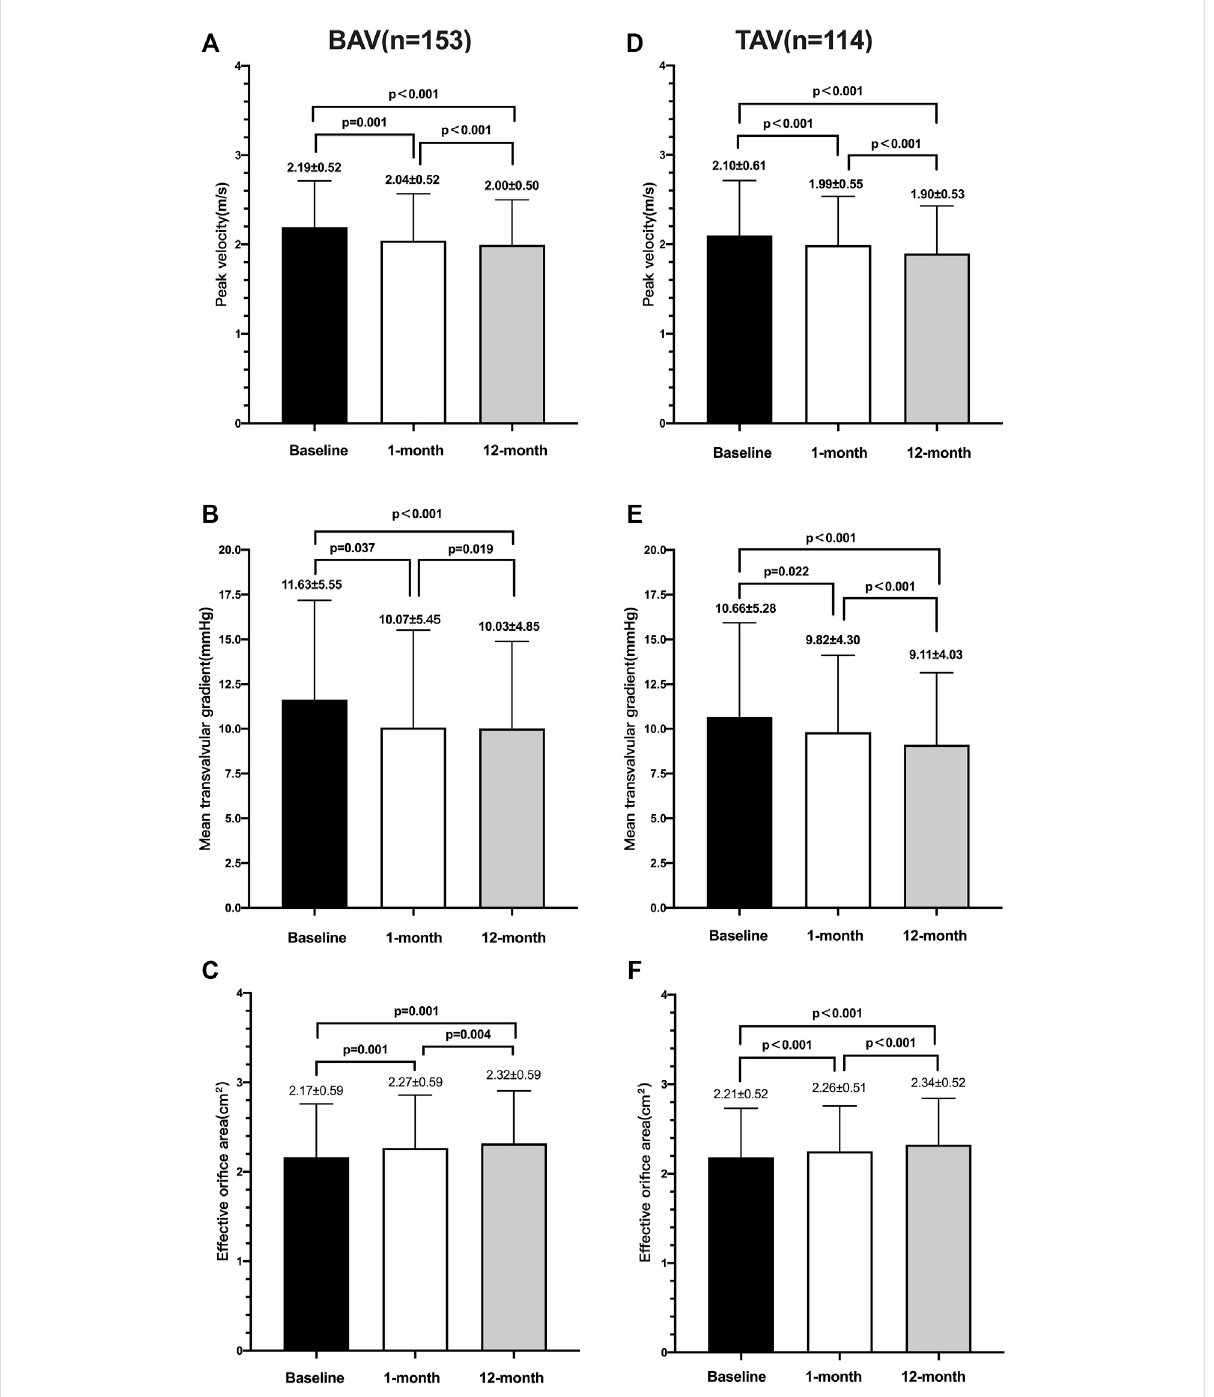
FIGURE 3 EchocardiographicparametersovertimebetweentheBAVandTAV.Changesofpeakvelocity (A) ,meantransvalvulargradient (B) ,andeffective ori fi ce area(mm 2 ) (C) inpatientswith thebicuspidaortic valve;changesofpeakvelocity (D) mean transvalvular gradient (E) ,andeffective ori fi ce area (mm 2 ) (F) in patients with the tricuspid aortic